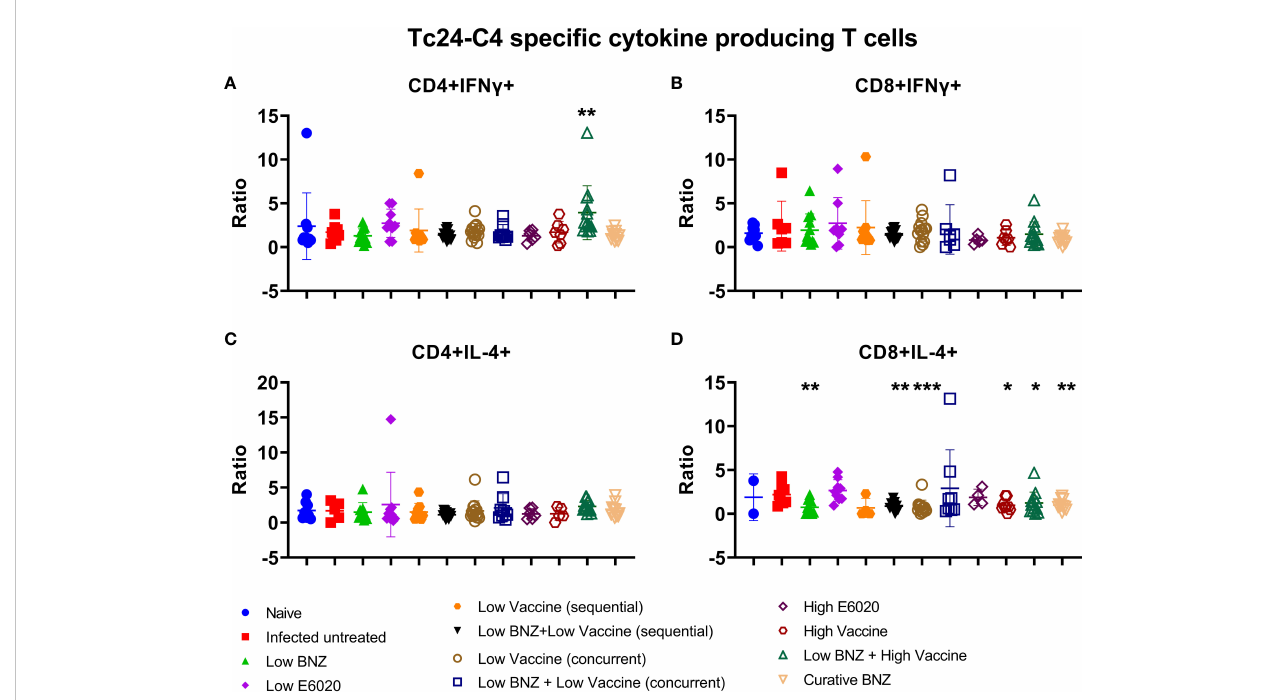
FIGURE 8 Antigen speci fi c cytokine producing T cells. Splenocytes were restimulated in vitro with recombinant Tc24-C4 protein or cRPMI alone (unstimulated), then stained with fl uorescent antibodies for analysis by fl ow cytometry as described. Results are expressed as a ratio of antigen speci fi c cells divided by